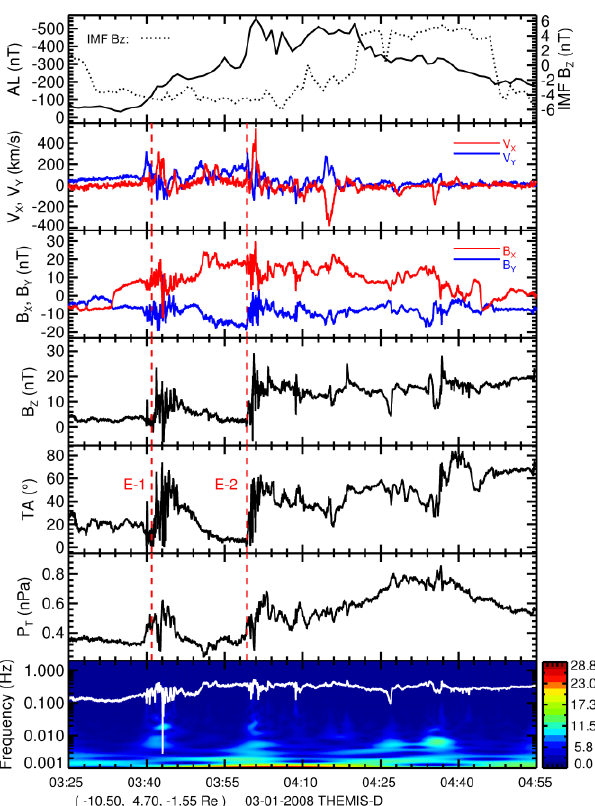
Fig. 1a. Summary plot of TH-D observations at ( − 10.50, 4.70, − 1.55 Re ), Kyoto-AL index from (of 1-min resolution) and OMNI- IMF B Z in GSM coordinates shifted to the nose of bow shock. The TH-D data include the flow speeds V X in red and V Y in blue (of 3-s resolution), the magnetic field components B X and B Z (of 0.25-s resolution) in the plasma sheet, the magnetic tilt angle TA from the equatorial plane, the thermal pressure P T , and the Morlet wavelet spectrum.